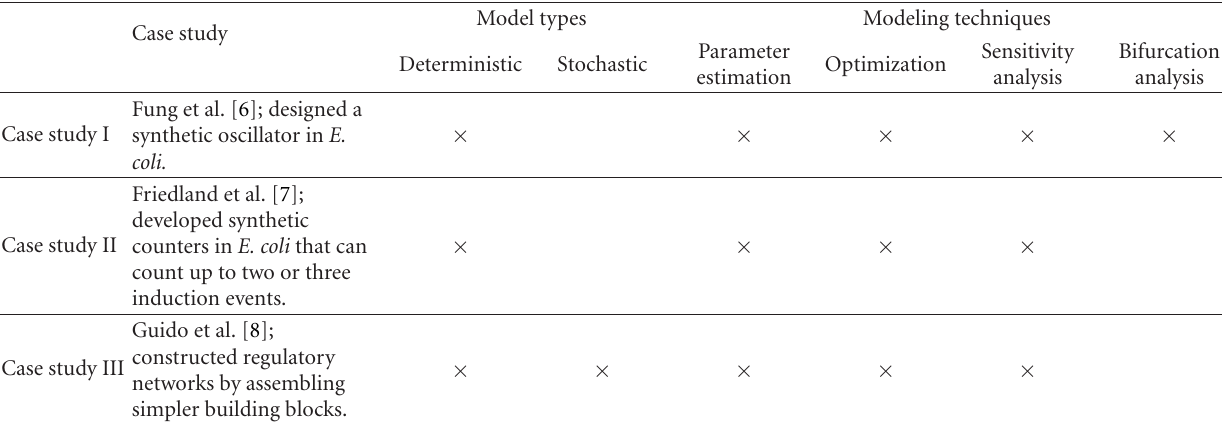
Table 1: Modeling techniques used in the case